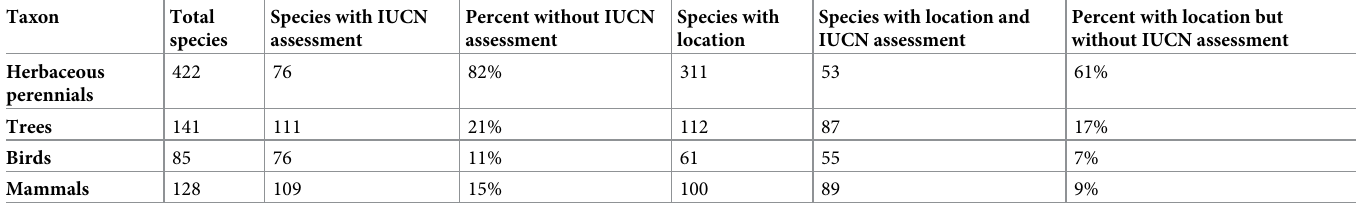
Table 2. Summary of species in the COMPADRE and COMADRE matrix